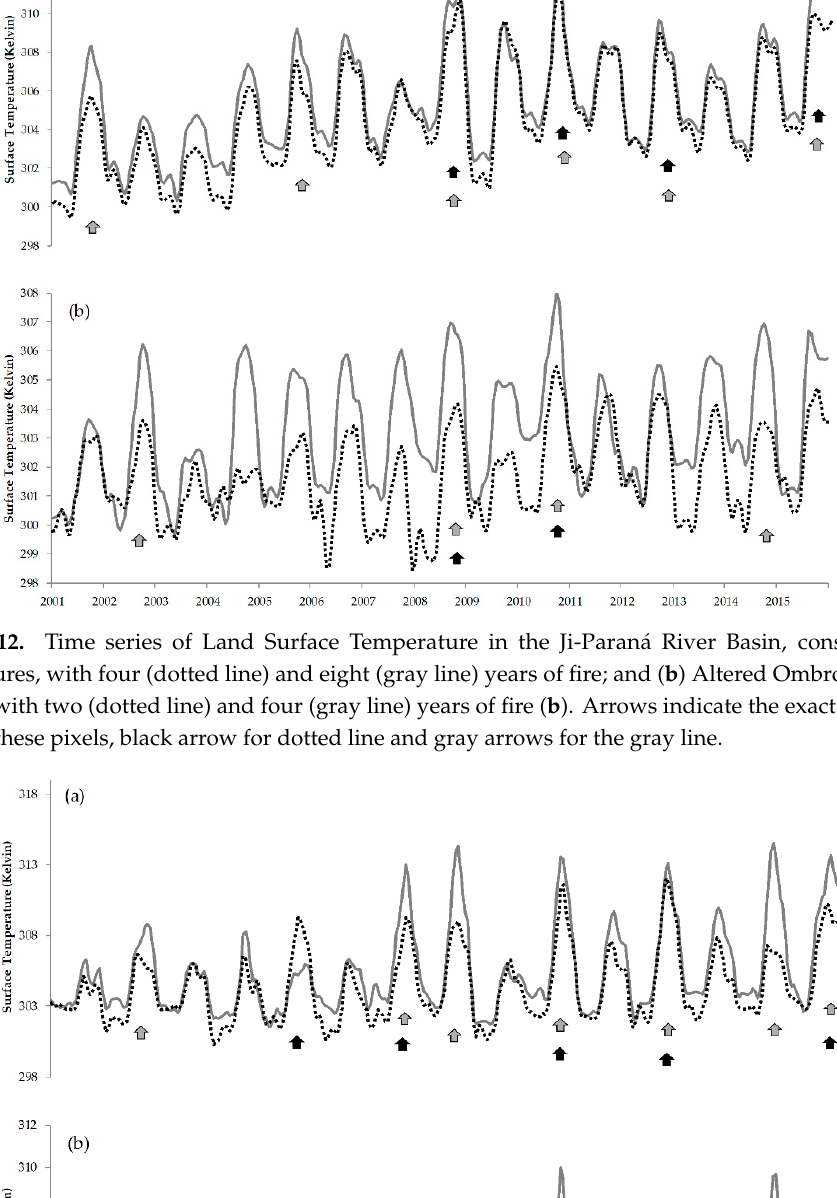
Figure 11. Time series of Enhanced Vegetation Index (EVI) in the Araguaia National Park and Cantão State Park, considering: ( a ) Altered Forested Savanna, with five (dotted line) and seven (gray line) years of fire; and ( b ) Grassy-woody Savanna, with six (dotted line) and seven (gray line) years of fire. Arrows indicate the exact dates of fires in these pixels, black arrow for dotted line and gray arrows for the gray line.